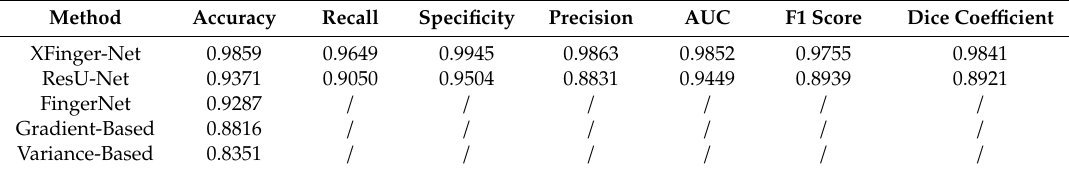
Table 5. The score of the segmentation algorithm on test dataset.